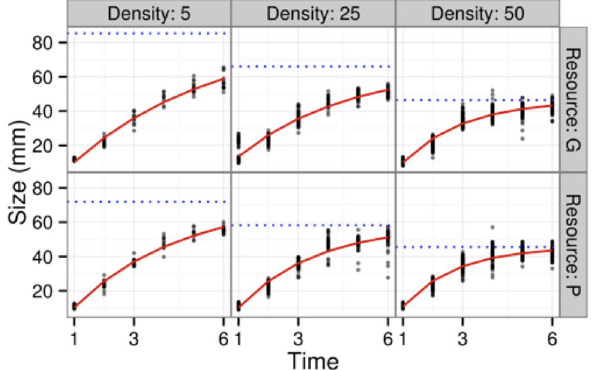
Figure 5. Data on red-eyed tree frogs: size (total length) in mm vs. time in days. Points represent tank means; red lines are estimated Michaelis-Menten growth curves; blue dotted lines are estimated asymptotic